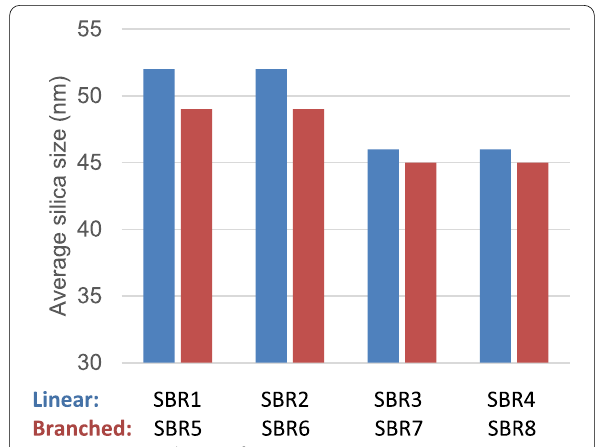
Fig. 14 Average silica size from SAXS measurement